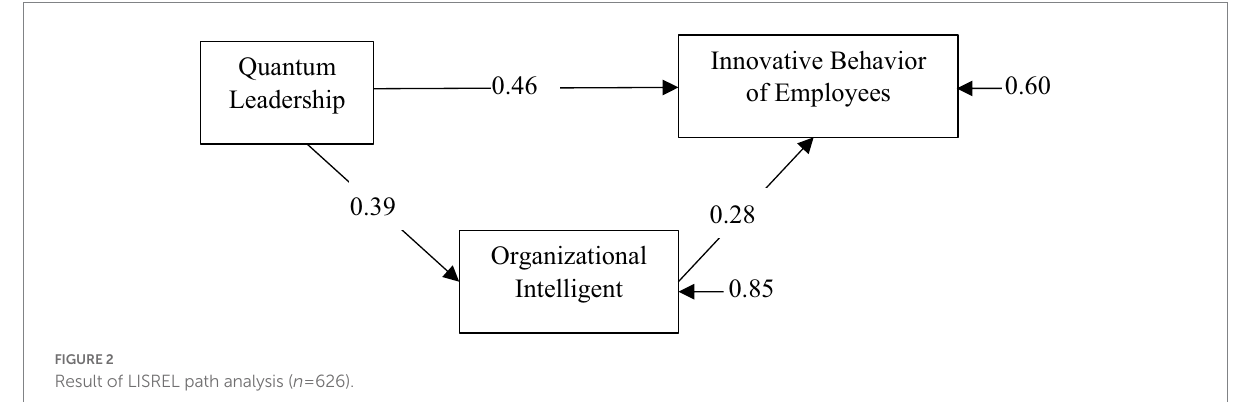
FIGURE 2 Result of LISREL path analysis ( n =